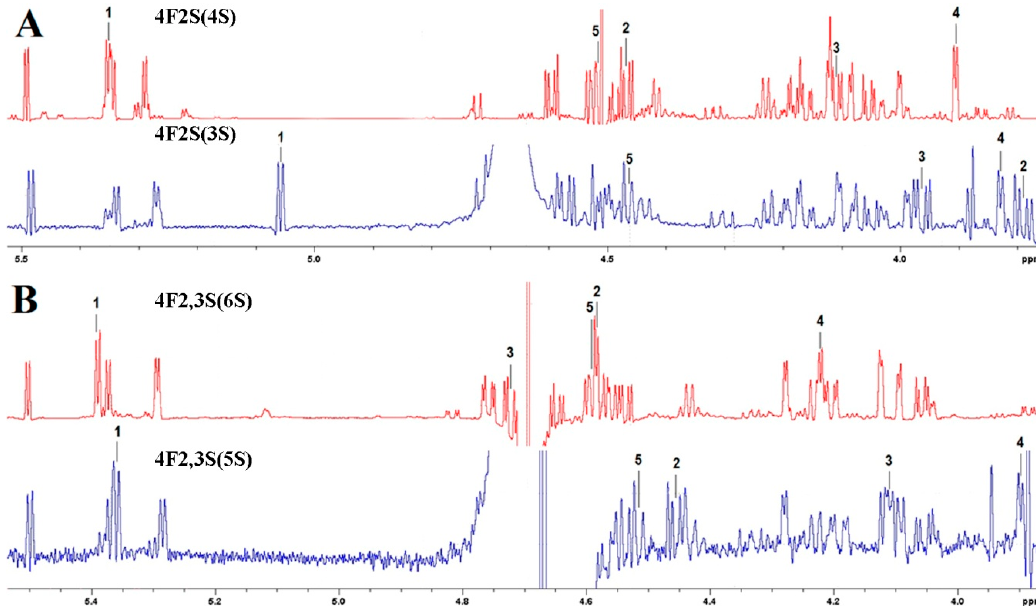
Figure 6. 1 H NMR spectra of tetrasaccharide 4F2S(4S) before (red) and after (blue) treatment by SWF1 (resulting oligosaccharide 4F2S(3S) ) ( A ) and tetrasaccharide 4F2,3S(6S) before (red) and after (blue) treatment by SWF4 (resulting oligosaccharide 4F2,3S(5S) ) ( B ); 1–5 are positions of the respective NMR chemical shifts of protons of the tetrasaccharides’ terminal fucose residues.